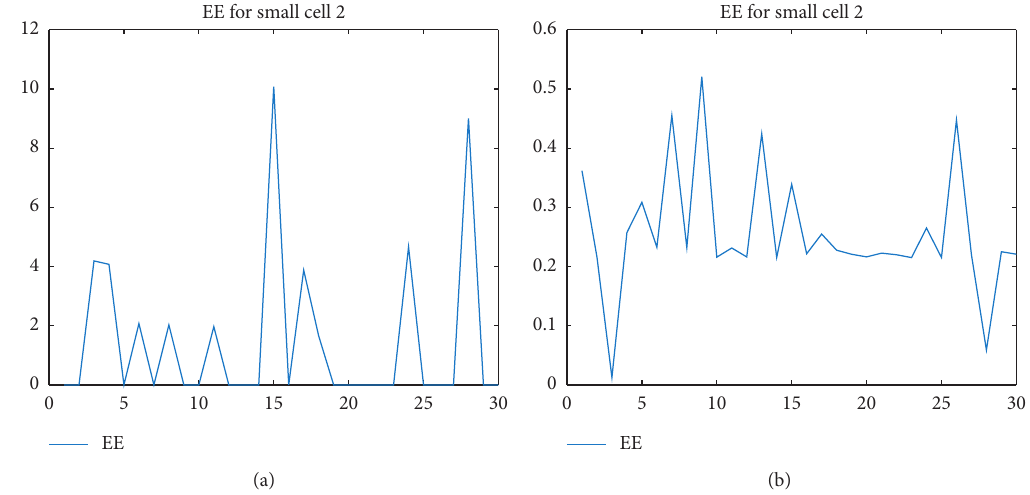
Figure 4: The energy efficiency (a) and SINR (b) of small BS 2 for 30 MUE macro.